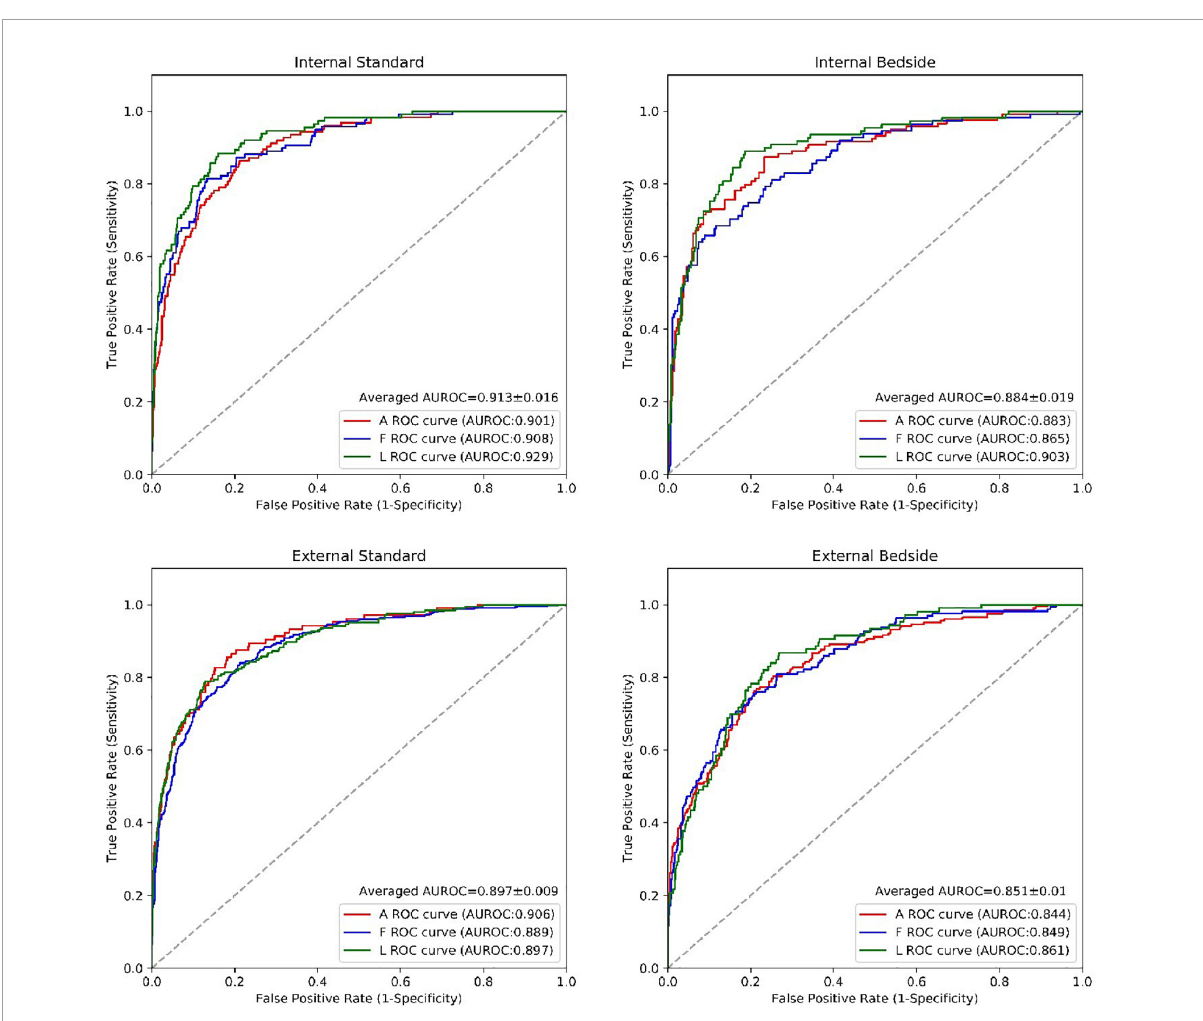
FIGURE4 The performance of the RWMAs detection model. The performance of the RWMAs detection model for bedside vs. standard cases in retrospective invalidation dataset and prospective testing dataset. Abbreviations as in Figure 2 .